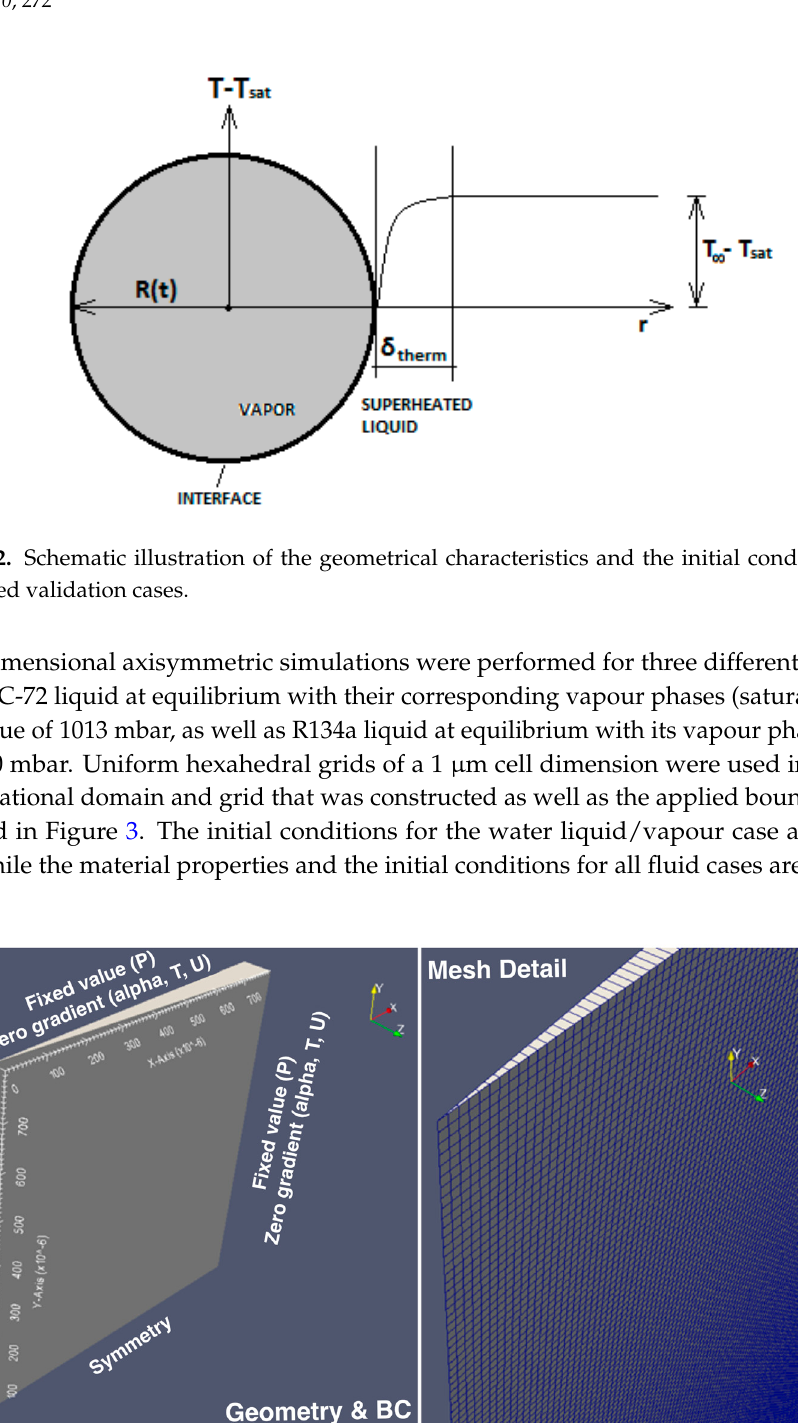
Figure 4. Initial conditions for the water liquid/vapour: P = 1.013 bar, 5 K of liquid superheat.